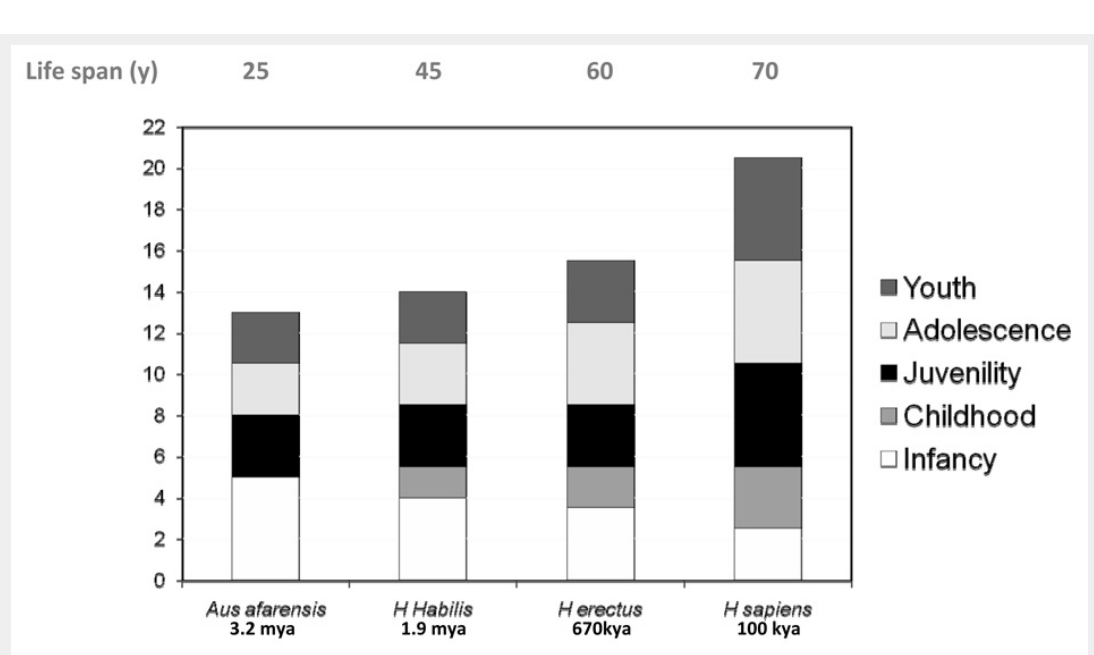
The evolution of hominid life history during the first 20 years of life. The existence time is given below (kyo – thousands years ago, myo – millions years ago) and the longevity – above. During the evolution of the hominids, childhood and adolescence have been added as new life- history stages as compared with apes and the presumably the early hominid Australophithecus afarensis . The chimpanzee serves as a living representative of the assumed Australophithecus afarensis life history. As childhood emerged and prolonged, infancy has gradually cut shorter, and the latest introduced adolescence came at the expense of a shorter